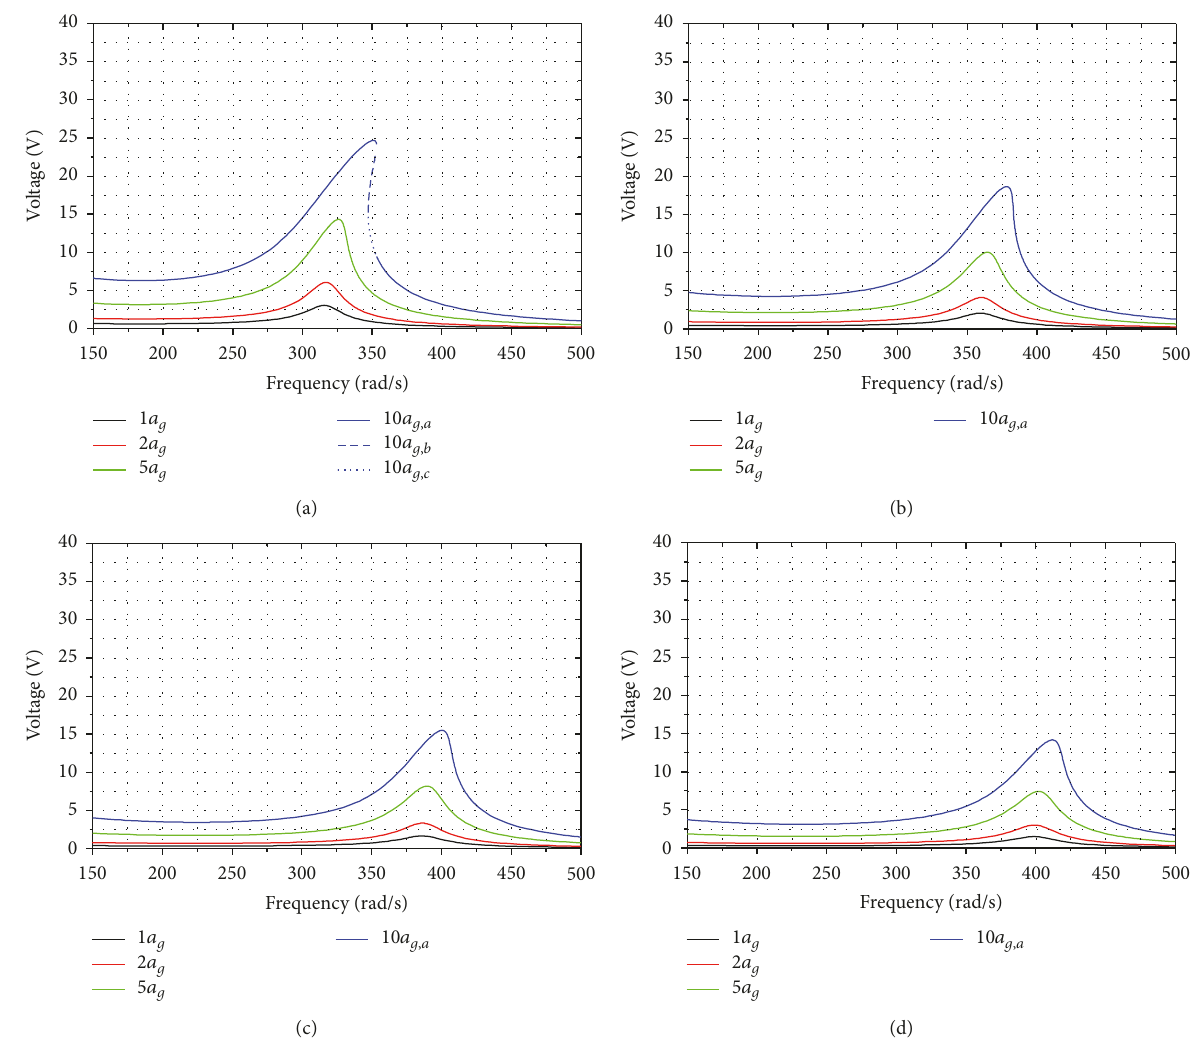
Figure 10: FRFs of the maximum voltage for base acceleration amplitudes ranging from 1 𝑎 𝑔 to 10 𝑎 𝑔 , where (a) 𝐸 PVDF = 𝐸 0 PVDF , (b) 𝐸 PVDF =